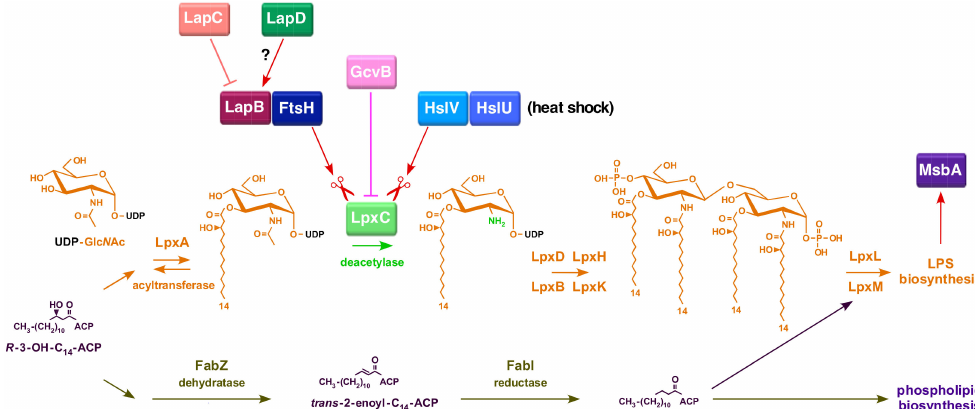
Figure 1. Key steps in the regulation of the first committed step in LPS biosynthesis catalyzed by LpxC and LPS transport mediated by MsbA across the inner membrane. Schematic illustration depicting utilization of the same metabolic precursor ( R )-3-hydroxymyristate by LpxA and by FabZ in LPS and phospholipid biosynthesis, respectively. As the reaction catalyzed by LpxA is thermodynamically unfavorable, LpxC-mediated deacylation constitutes the first committed step in LPS biosynthesis. LpxC amounts are regulated by its turnover by the FtsH-LapB complex and at high temperature by HslVU protease. LapC acts as an antagonist of LapB to regulate LPS biosynthesis as per its demand. Once LPS is assembled, it is flipped across the inner membrane by MsbA for its further transport. Scissors depict proteolysis by FtsH and HslVU proteases. A newly identified LapD protein that co-purifies with LapB is depicted with a question